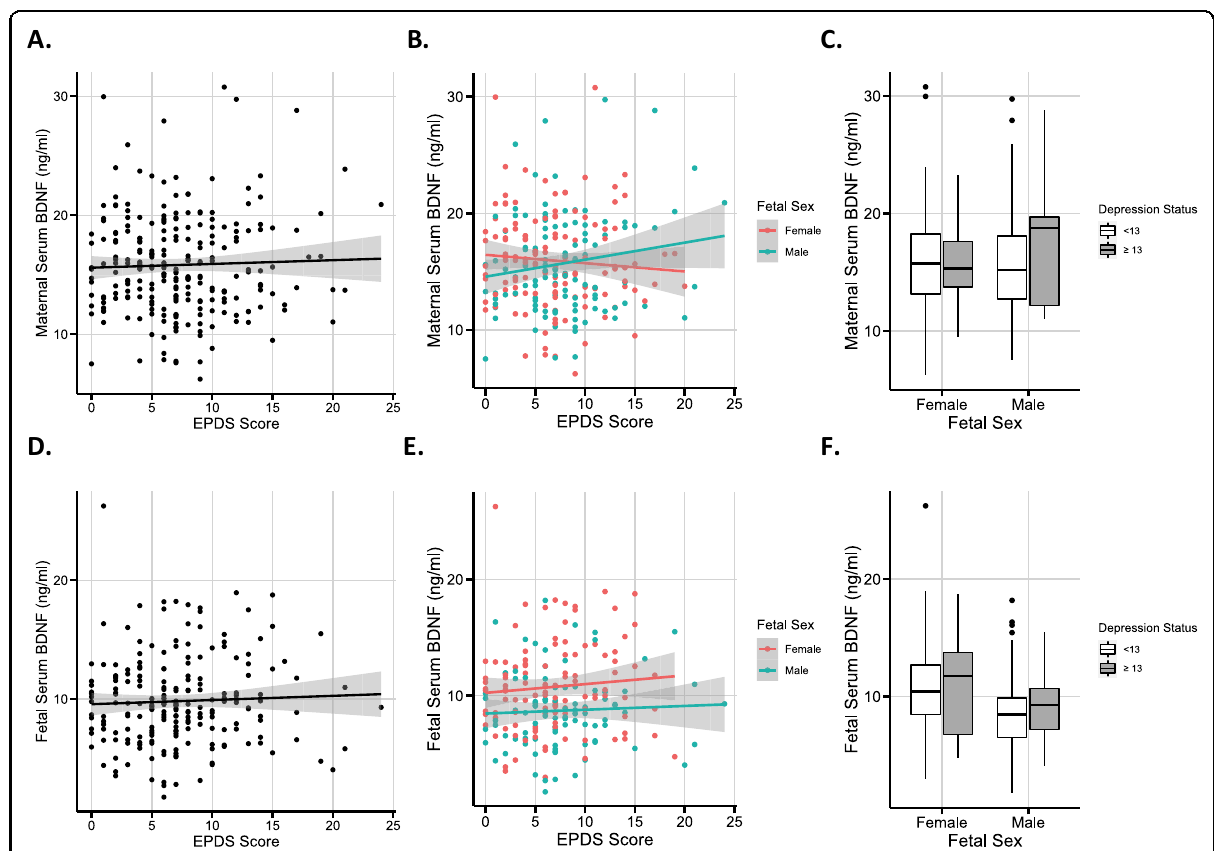
Fig. 2 No correlation between serum BDNF levels and maternally reported depression symptoms. A , B Maternal serum BDNF values plotted against EPDS scores, using ( A ) the whole population ( r = − 0.022, P = 0.733, n = 244), and ( B ) split by fetal sex (female: r = − 0.1, P = 0.258, n = 131; male: r = 0.06, P = 0.522, n = 113, Spearman ’ s rank correlation). C Comparison of maternal serum BDNF values across depression categories and separated by fetal sex ( n : female infants, EPDS < 13: 112; ≥ 13: 19; male infants, EPDS < 13: 98; ≥ 13: 15). D , E Fetal serum BDNF values plotted against EPDS scores, using ( D ) the whole population ( r = 0.060, P = 0.394, n = 206), and ( E ) split by fetal sex (female: r = 0.13, P = 0.176, n = 111; male: r = 0.05, P = 0.660, n = 95, Spearman ’ s rank correlation). F Comparison of fetal serum BDNF values across depression categories and separated by fetal sex ( n : female infants, EPDS< 13: 94; ≥ 13: 17; male infants, EPDS < 13: 84; ≥ 13: 11). Note: fewer samples were available for the fetal serum analysis. EPDS: Edinburgh postnatal depression score. 95% con fi dence intervals are shaded in gray. Boxplot values indicate the following: Box boundaries, 25% and 75% quartiles; mid-line, median; whiskers, highest and lowest values within 1.5 × IQR of the box boundary; outliers, values outside the